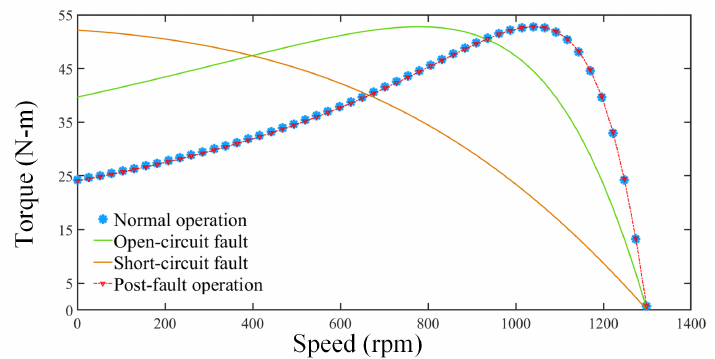
Figure 14. Torque-speed characteristics of the induction motor under fault-tolerant